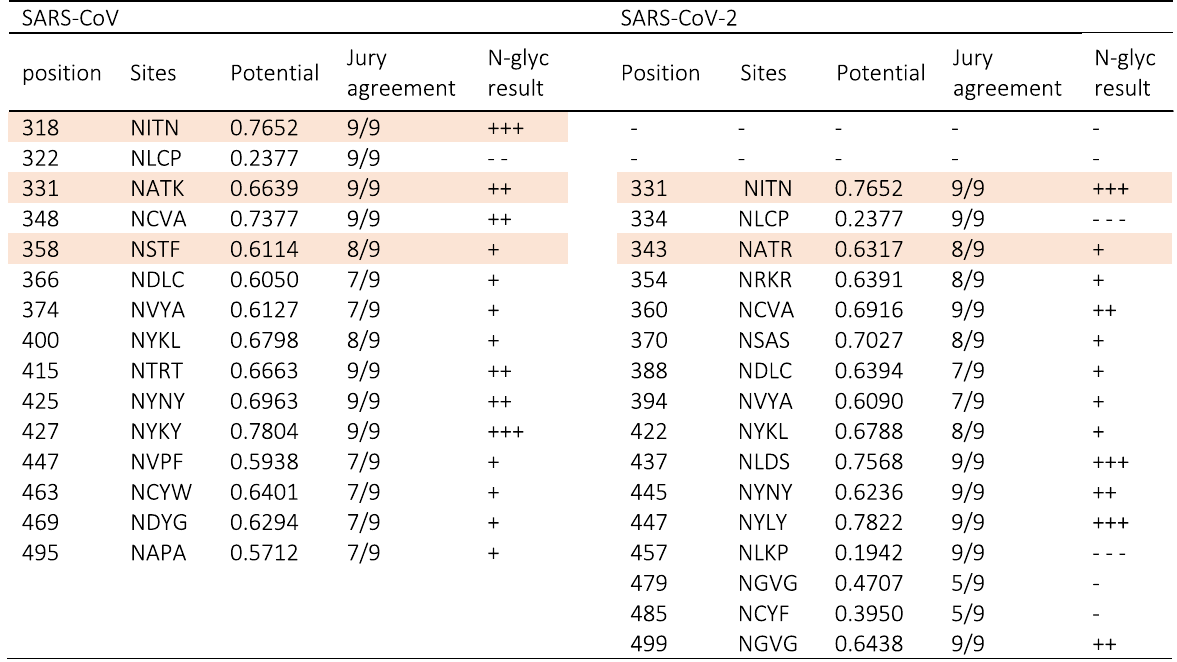
Table 2 List of the predicted glycosylation sequences and the potential N-glycosylated sites in vivo were colored purple.